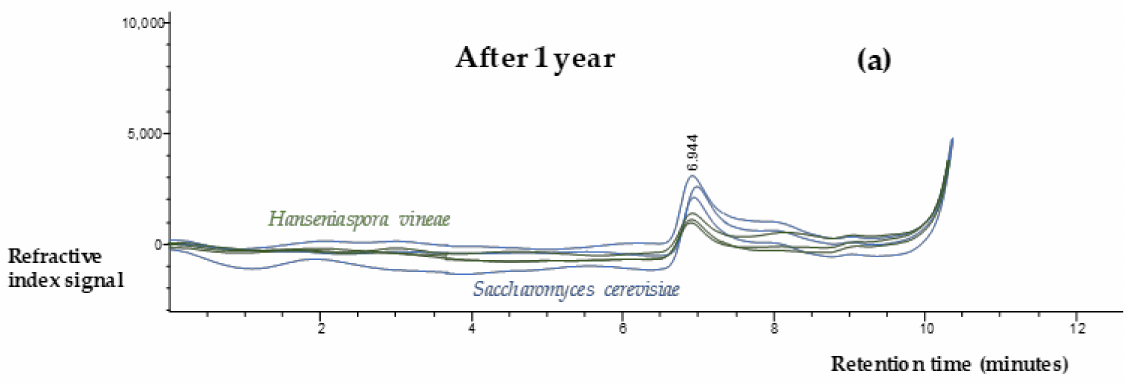
Figure 2. Total polyphenol index (absorbance units) ( A ), colour intensity (absorbance units) ( B ), and tonality (dimensionless) ( C ). Mean ± SD for three replicates. Bars with the same letter are not significantly different ( p <